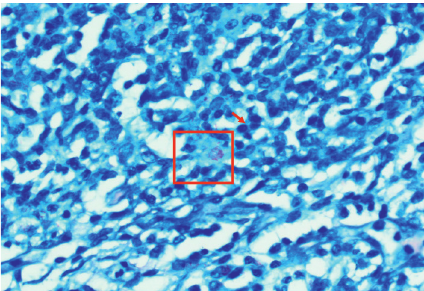
Figure 2: The lymph node effaced and replaced by a sheet of histiocytes; lymph node remnant seen as scattered lymphocytes and small lymphoid aggregates (arrow). There are necrotic foci within the histiocytes sheet (upper half of the picture). Ziehl–Neelsen stain showing numerous acid-fast bacilli (the red box region). The acid- fast bacilli are red color rods.